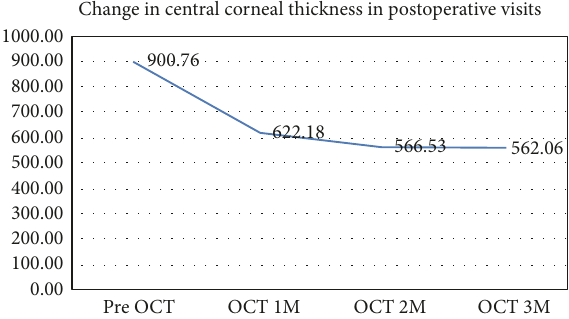
Figure 1: Change in central corneal thickness overtime from preoperative values to 3 months postoperatively.